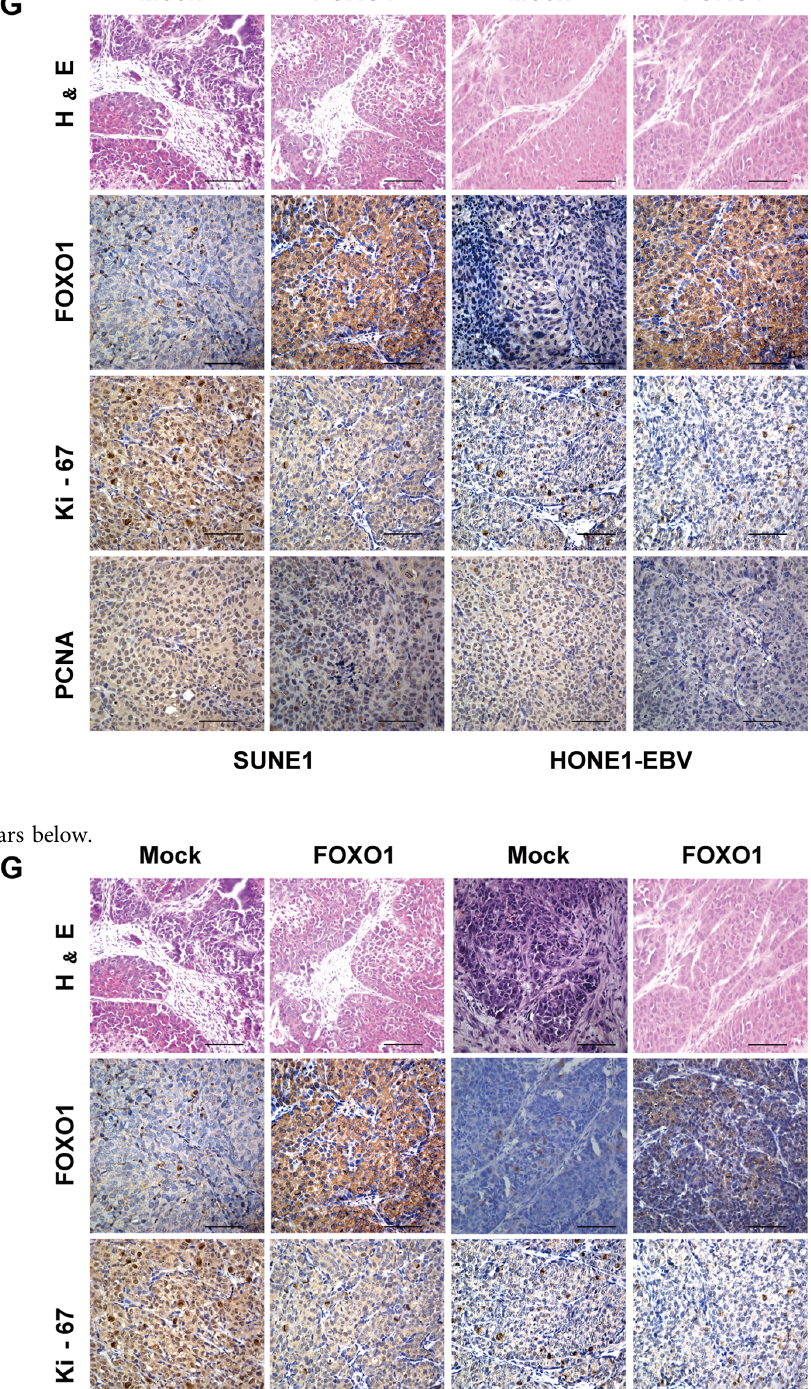
The incorrect image appears below.